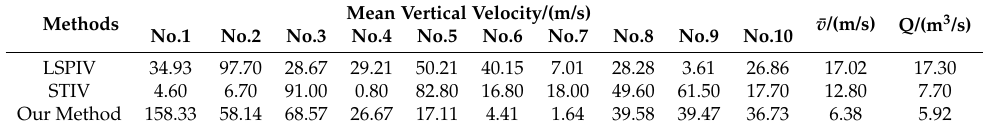
Table 15. Relative error comparison.